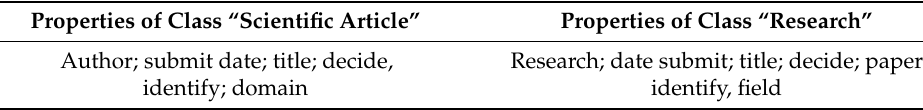
Table 5. Data properties after applying